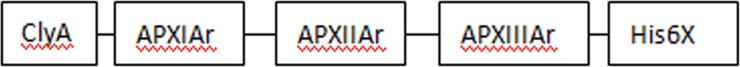
The structure of ClyA-Apxr.ClyA-Apxr constructs terminated by a 6x histidine-tag were expressed in E. coli JC8031, Apxr contains a fragment of ApxIAr, ApxIIAr and ApxIIIAr.